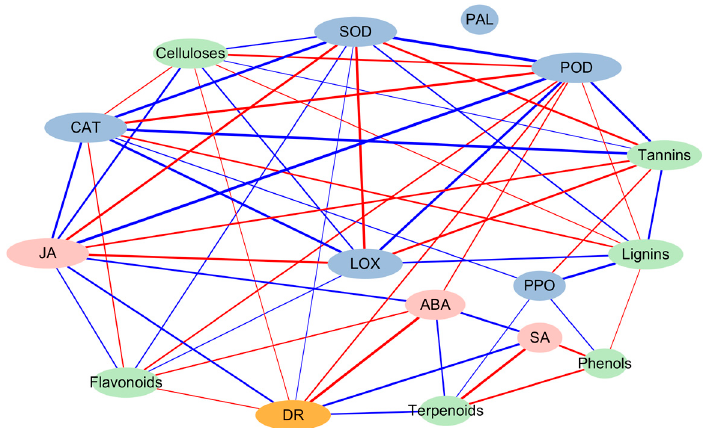
Figure 4. Pearson correlation analysis among hazelnut damage rate (DR), resistant-insect compounds, enzyme activities, and plant hormones.